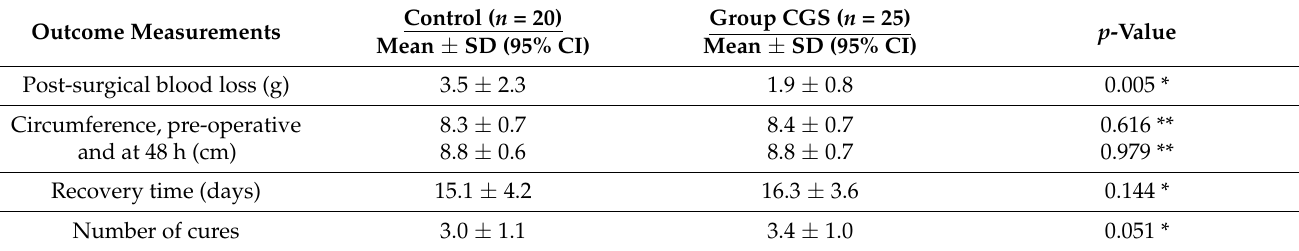
Table 3. Comparison of the outcome between the control group and the experimental Group